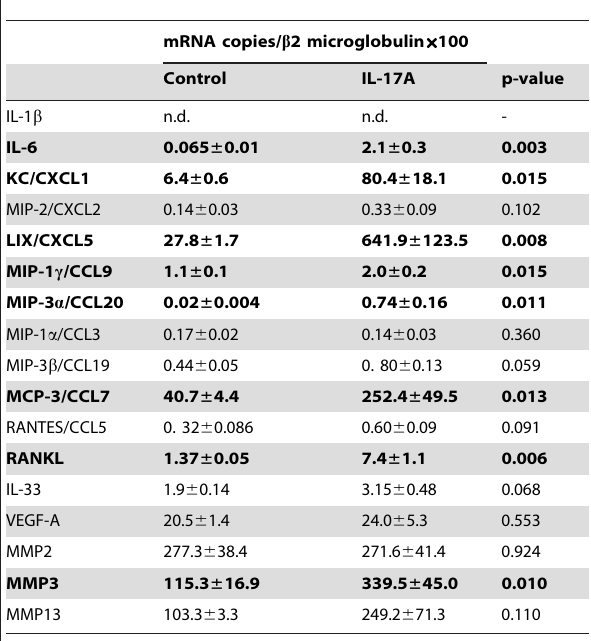
Table 2. Gene expression in FLS after stimulation with